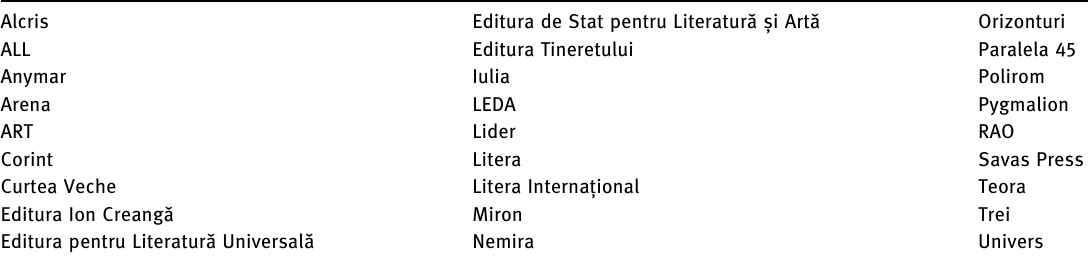
Table 3: List of publishing